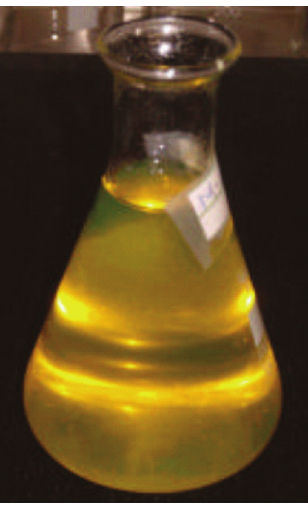
Figure 2: Homogeneous mixture after undergoing heating and